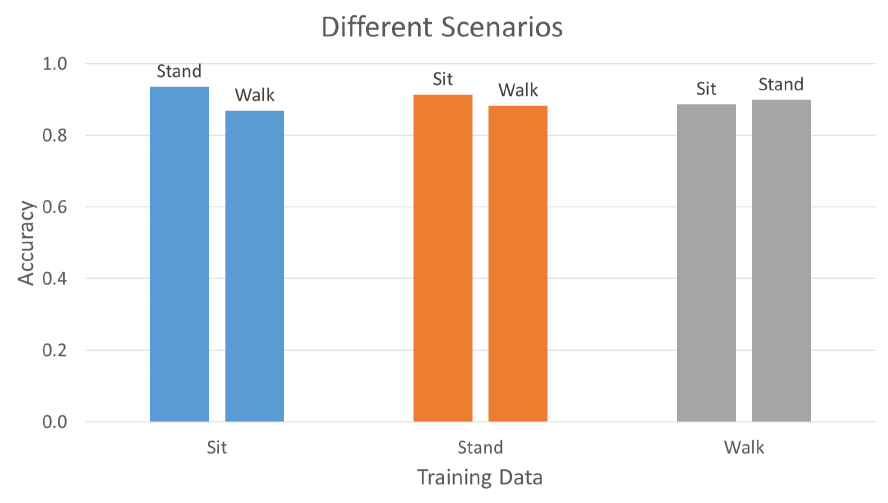
Figure 8. Different training scenario with different testing